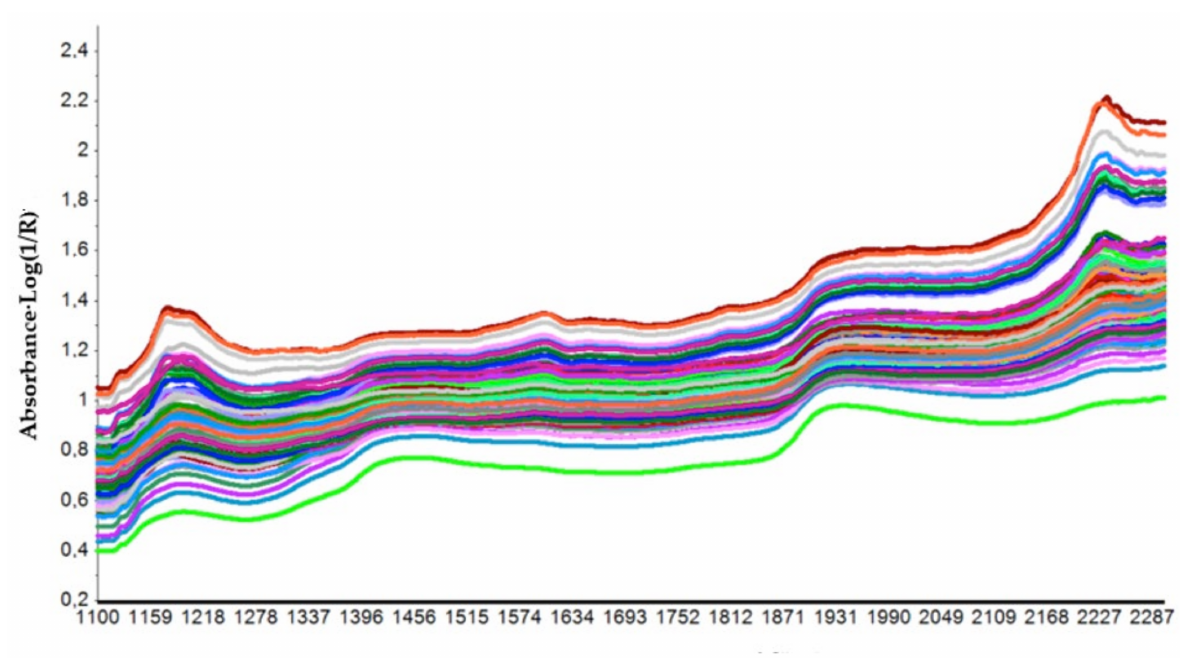
Figure 3. NIR raw-spectra collected with a Brimrose Luminar 5030 AOTF-NIR spectrometer